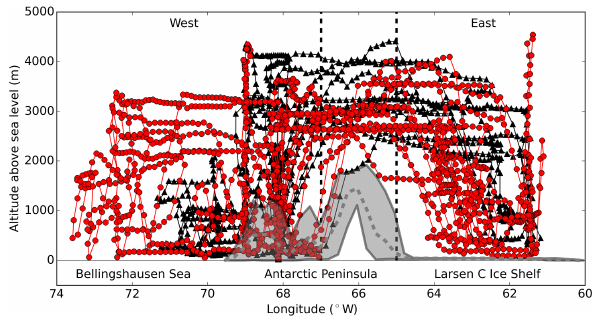
Figure 2. Latitudinal cross-section of flight tracks showing altitudes probed on both sides of the peninsula. February 2010 (black trian- gles) and January 2011 (red circles). The grey shaded area delimits the maximum and minimum topography height (at 5km resolution) between 68 and 67 ◦ S, and the grey dashed line shows the aver- age topography height across the latitudes 68 to 67 ◦ S. The verti- cal dashed lines delimit the western (74–67 ◦ W) and eastern (65– 60 ◦ W) regions of the peninsula as defined in this